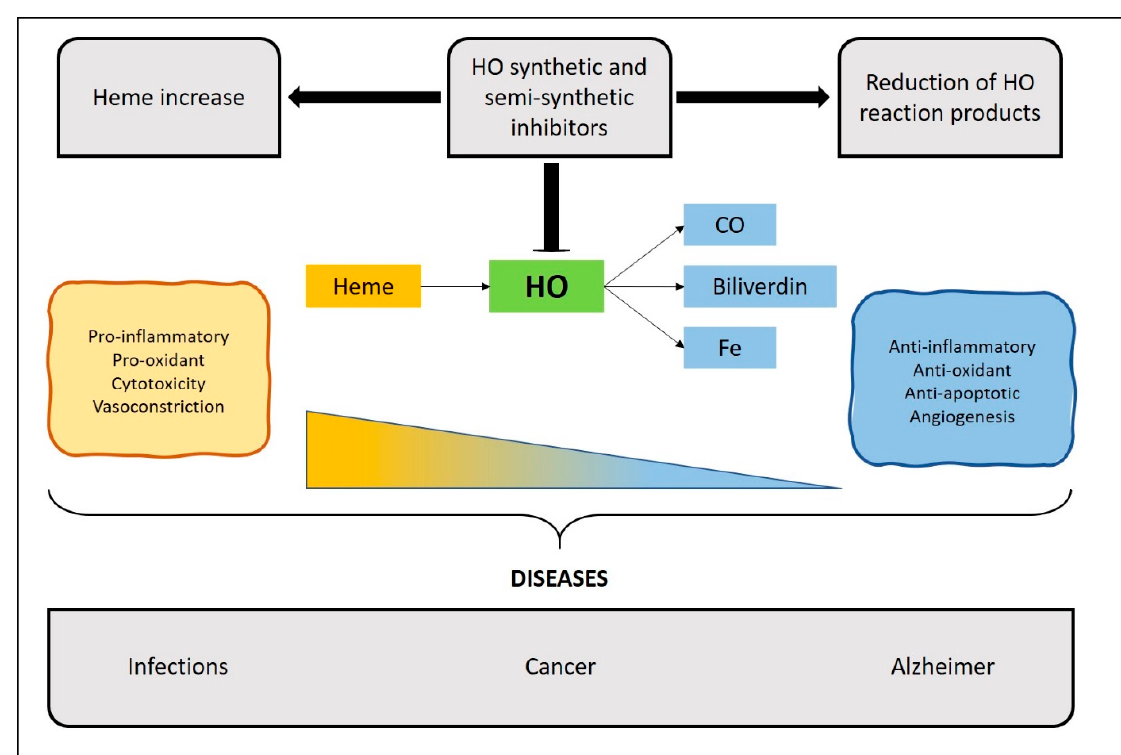
Figure 3. Schematic representation of the effect of HO enzyme inhibition in immune-mediated diseases.